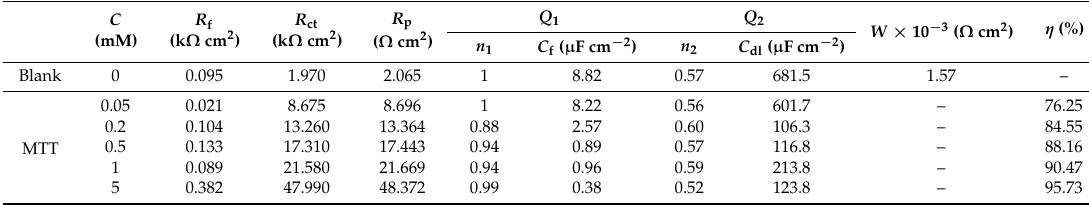
Table 1. The related parameters of EIS for copper electrode in 3% NaCl at 298 K.